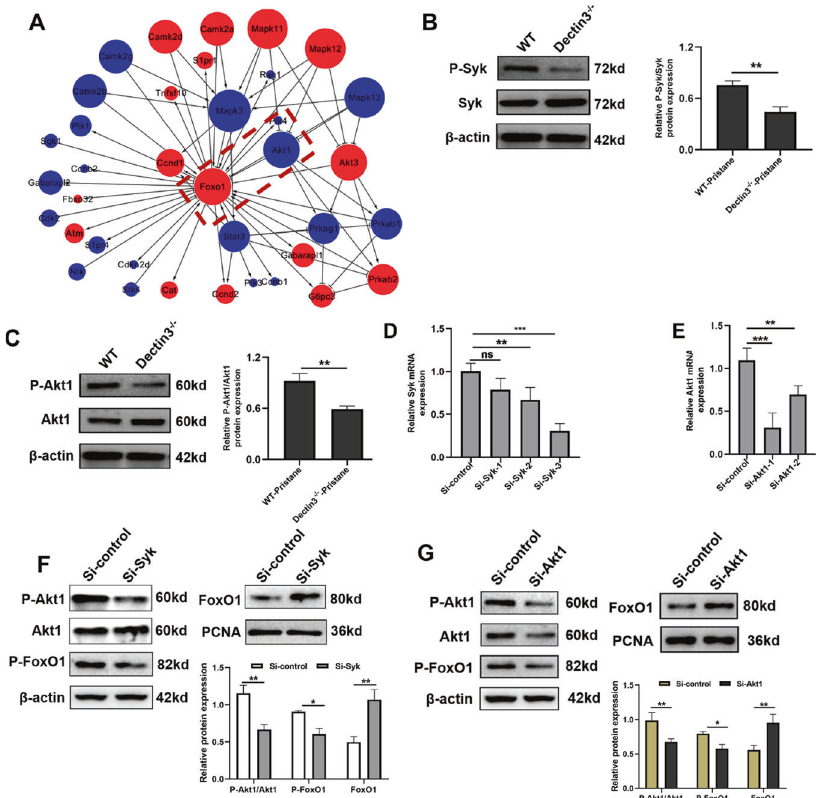
Fig. 4 Syk-Akt1-mediated nuclear transfer of FoxO1 was inhibited in Dectin3-de fi cient MDSCs. A Gene co-expression network analysis showed that FoxO1 was signi fi cantly related to Akt1. B P-Syk and Syk protein expression was evaluated by western blot analysis in MDSCs isolated from WT mice and Dectin3 − / − mice with lupus. C P-Akt1 and Akt1 protein expression were evaluated by western blot analysis in MDSCs isolated from WT mice and Dectin3 − / − mice with lupus. D Interference ef fi ciency of RNA fragments of Syk evaluated using qPCR. E Interference ef fi ciency of RNA fragments of Akt1 by qPCR. F P-Akt1, Akt1, P-FoxO1, and FoxO1 protein expression was detected by western blot analysis in BM-MDSCs after interference with Syk. G Western blot detection of P-Akt1, Akt1, P-FoxO1, and FoxO1 protein expression levels after interference with Akt1. Data represent the mean scores ± SEM. * P ≤ 0.05, ** P ≤ 0.01, *** P ≤ 0.001; n = 3 per group.